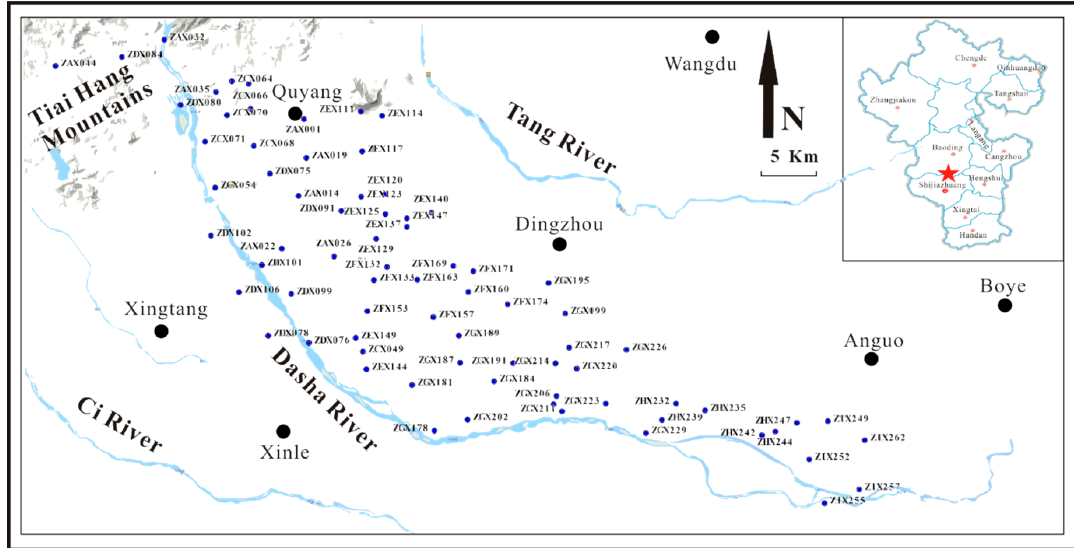
Figure 1. The distribution of shallow groundwater sampling points.